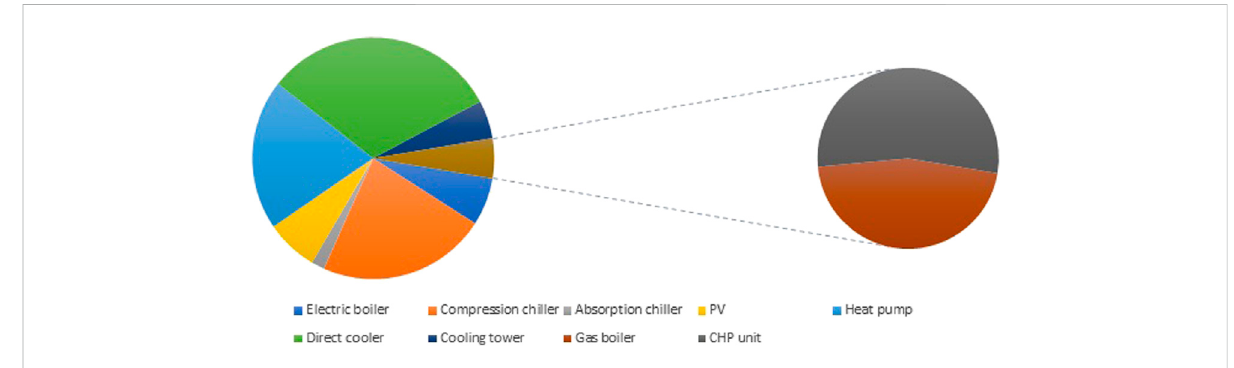
FIGURE 11 Distribution of the total capacity across the dimensioned technologies with separat focus on gas-based technologies from Wirtz et al.